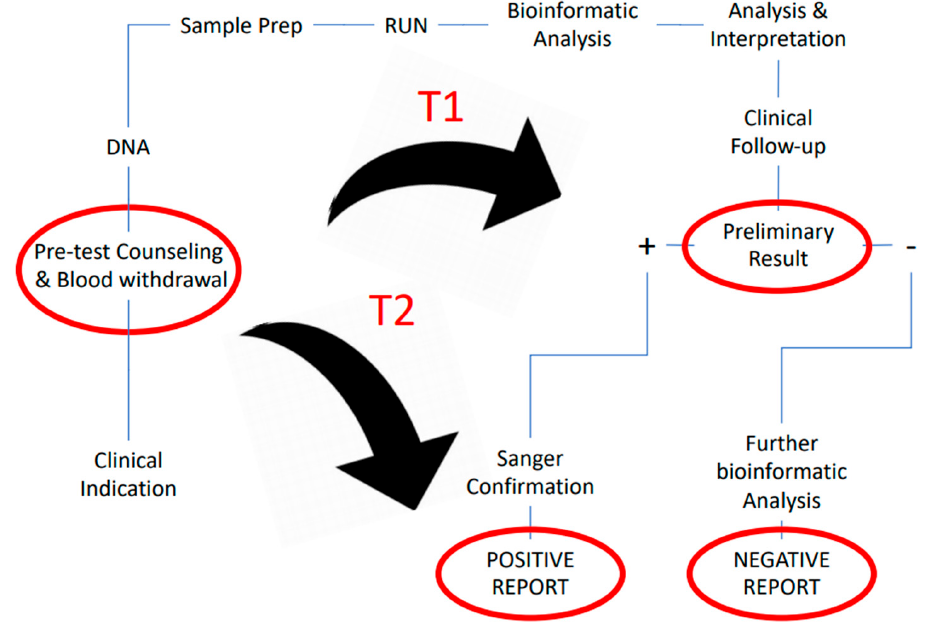
Figure 1. Measurement of turnaround time (TAT) of WES analysis in urgent and non-urgent settings. T1: time to preliminary result, T2: time to definitive report.